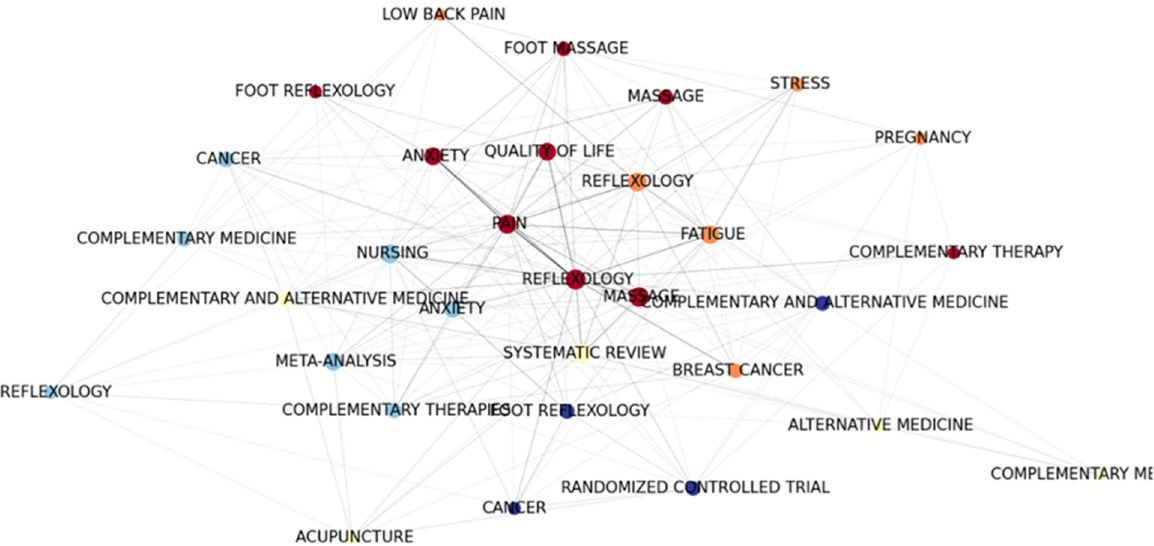
Figure 9. Reflexology keyword co-occurrence clustering graph. Figure 8. Reflexology keyword co-occurrence clustering graph.